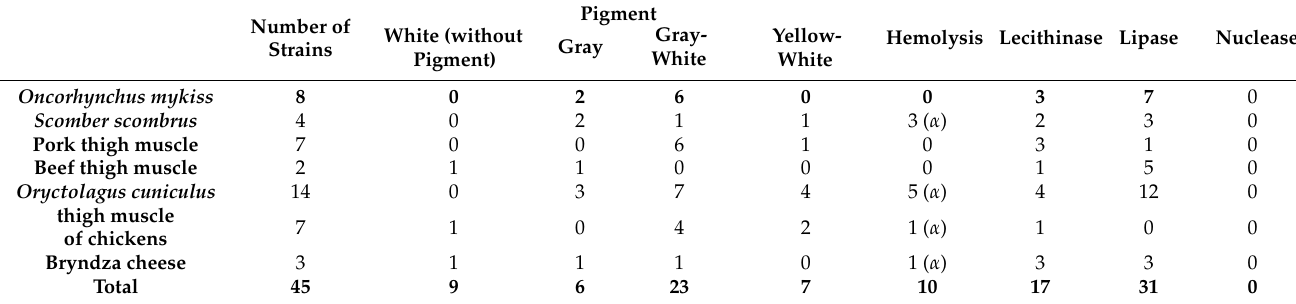
Table 2. Virulence phenotypic properties of S. warneri